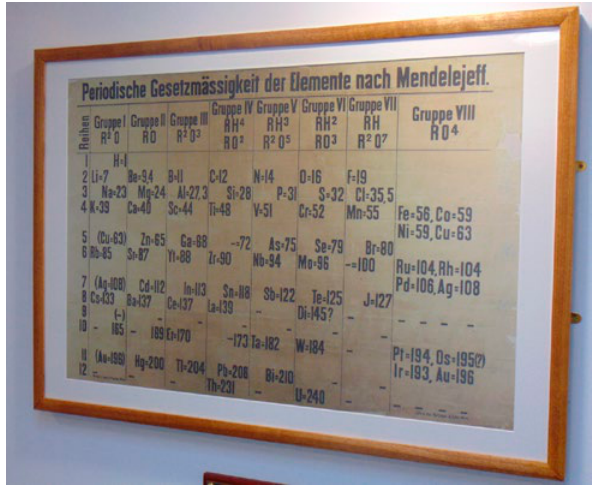
Figure 3. Facsimile of the St Andrews Table on display following conservation. University of St Andrews School of Chemistry. R.